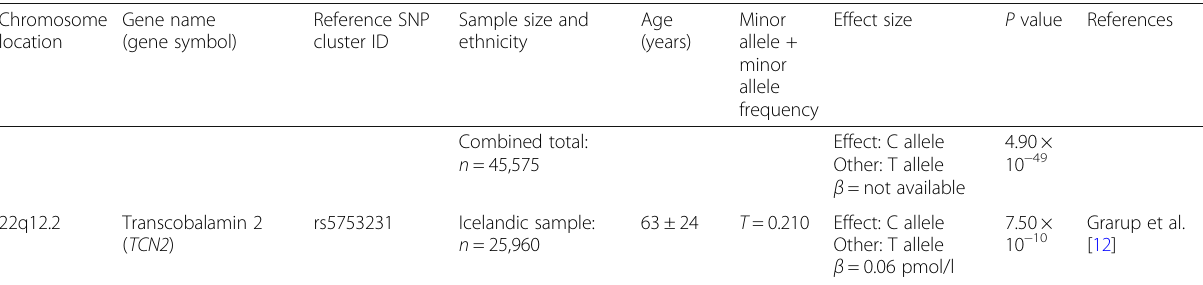
Table 1 Genome-wide association studies showing the association of SNPs with vitamin B12 concentrations. Genome-wide association studies testing the association between SNPs and vitamin B12 concentrations. The chromosome location, gene name, reference SNP cluster ID, sample size and ethnicity, mean age, observed frequency of the minor allele in the population, effect size and P value are shown in the table. The order of SNPs reflects the order of the chromosome location